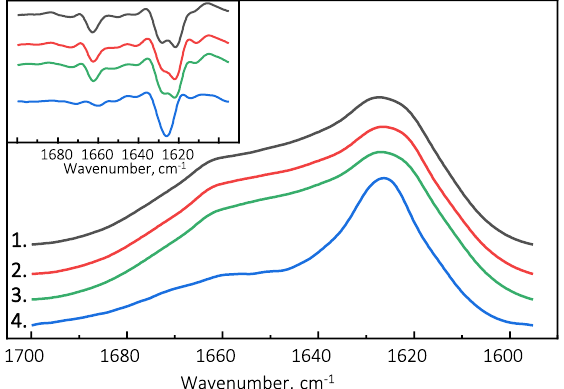
Figure 3. Absorbance and second derivative (inset) FTIR spectra of PrP(89-230) and PrP(107-143) fibrils. 1.—Spontaneously formed PrP(89-230) fibrils. 2.—Fibrils formed in the presence of 1% of PrP(89-230) fibrils. 3.—Fibrils formed in the presence of 10% of PrP(107-143) fibrils and 1% of PrP(89-230) fibrils. 4.—Spontaneously formed PrP(107-143)